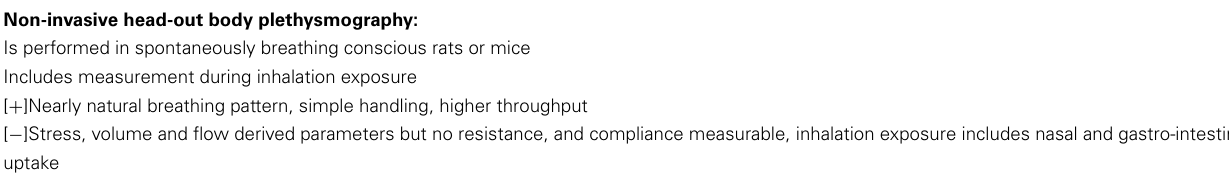
FIGURE 7 | Development of respiratory parameters in non-anesthetized juvenileWistar rats. (A) Tidal volume; (B) tidal midexpiratory flow; ∗ p < 0.05 male vs. female; mean values ± SEM, measured values of n = 8/sex (except males on post-natal day (PND)